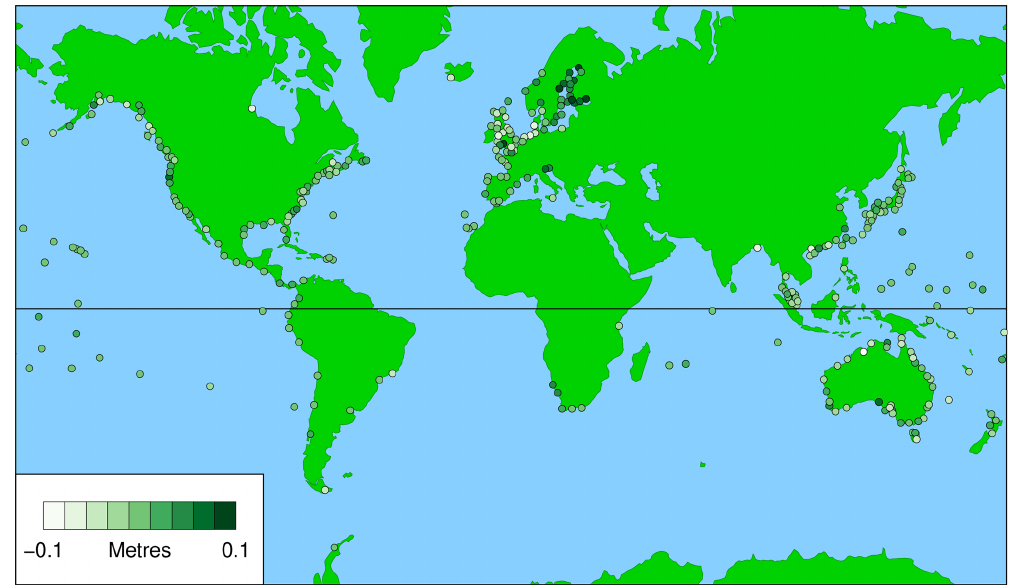
Figure 6. Averaged third metric , which is height of highest observed sea level on day of highest predicted tide for the year above highest predicted tide for the year, for daylight days ( o d (I pd (j,k),j,k) − p d (I pd (j,k),j,k) ), averaged over all valid years, j